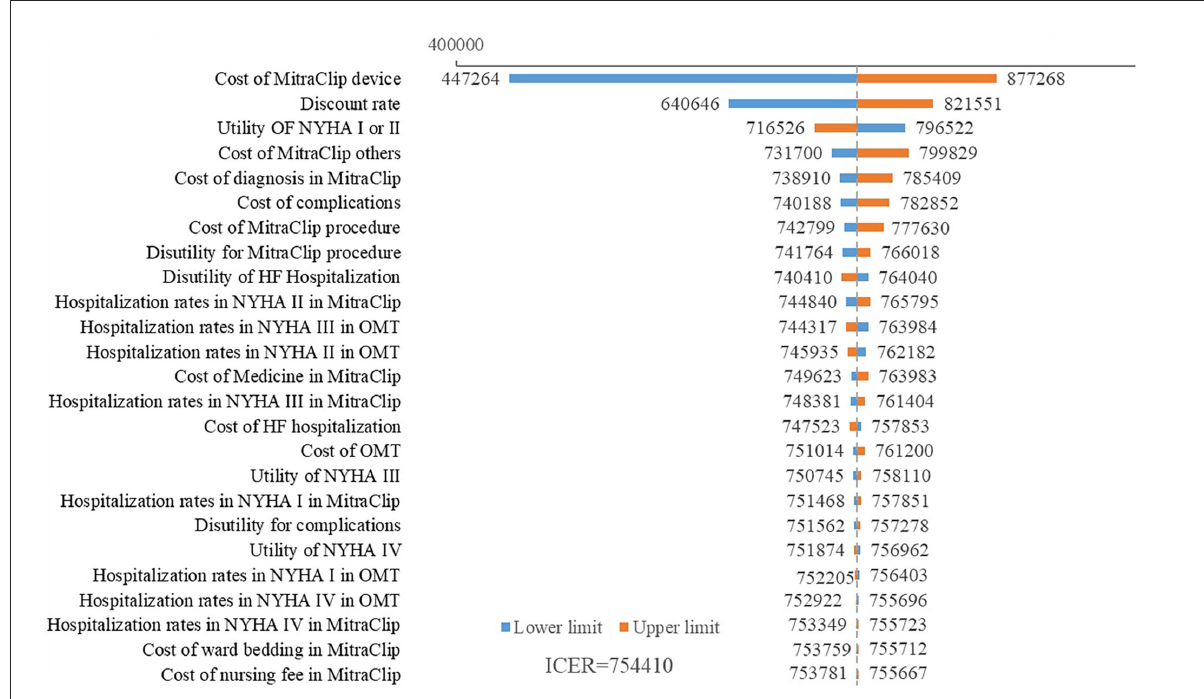
FIGURE2 Tornado diagram of ICER based on different input parameters. The cost of the MitraClip device had the largest impact on the ICER fluctuation. The discount rate also impacted the ICER. Other parameters had little impact on the ICER.